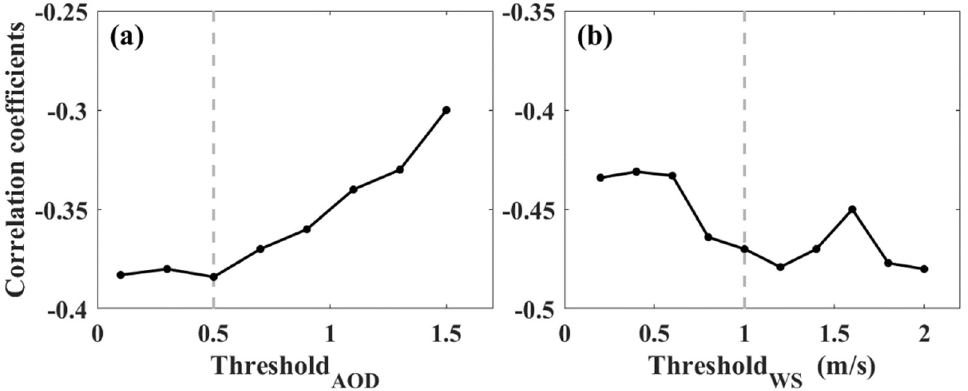
Figure 8. Correlation coefficients between hourly mean RLHs and PM 2.5 under different ( a ) threshold AOD and ( b ) threshold WS values.